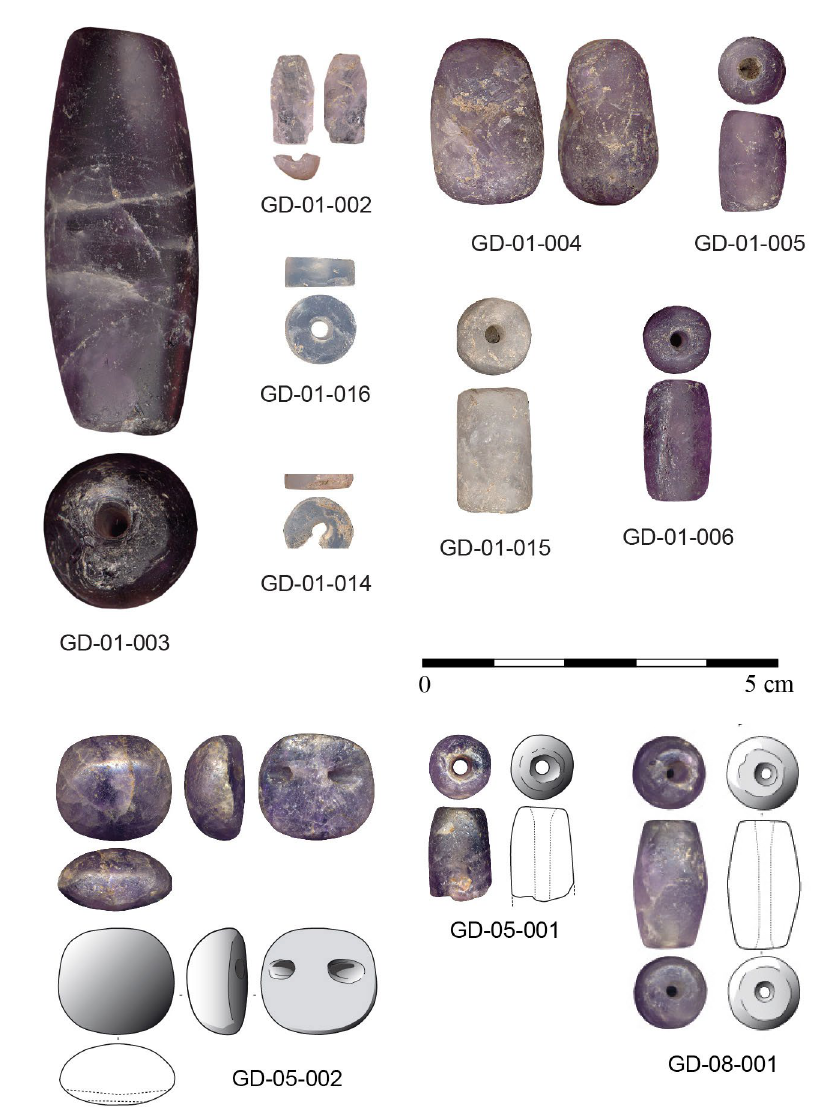
Figure 2: Photographs and drawings of beads from Gare Maritime (GD-01), Allée Dumanoir (GD-05), and Anse Ste Marguerite (GD-08),